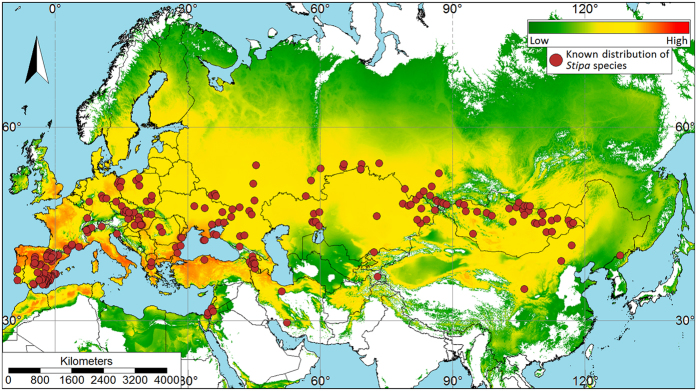
Maps of potentially suitable niches for representatives of the genus Stipa.Circles represent known locations of Stipa species. Scale bars show Maxent logistic output (used for visualization purposes); higher values (warmer colours) indicate higher predicted suitability. The map was plotted using SAGA GIS 3.0.060 (http://www.saga-gis.org); projection – World Mercator (EPSG: 3395).